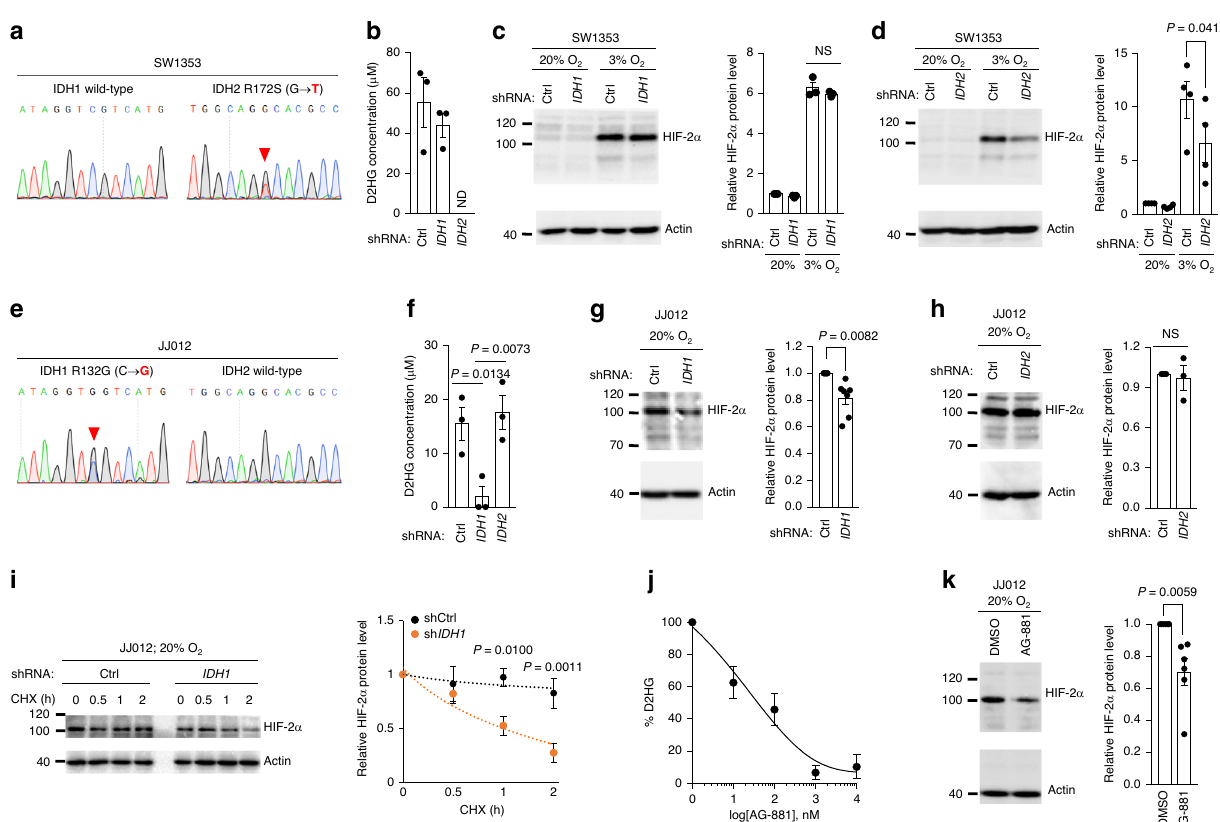
Fig. 5 IDH mutation causes stabilization of HIF-2 α in chondrosarcoma cells. a Sanger sequencing con fi rmed the heterozygous mutation of IDH2 R172S (AGG > AGT) in SW1353 cells. Red arrowhead indicates the mutated site in the IDH2 sequence. b Intracellular D2HG levels in SW1353 cells harboring the indicated shRNA ( n = 3). ND; not detected. c Immunoblot analysis of HIF-2 α protein in SW1353 cells harboring Ctrl or IDH1 shRNA ( n = 3). d Immunoblot analysis of HIF-2 α protein in SW1353 cells harboring Ctrl or IDH2 shRNA ( n = 4). e Sanger sequencing con fi rmed the heterozygous mutation of IDH1 R132G (CGT > GGT) in JJ012 cells. Red arrowhead indicates the mutated site in the IDH1 sequence. f Intracellular D2HG levels in JJ012 cells harboring the indicated shRNA ( n = 3). g Immunoblot analysis of HIF-2 α protein in JJ012 cells harboring Ctrl or IDH1 shRNA ( n = 7). h Immunoblot analysis of HIF-2 α protein in JJ012 cells harboring Ctrl or IDH2 shRNA ( n = 3). i Cycloheximide (CHX) chase analysis of HIF-2 α protein in JJ012 cells harboring Ctrl or IDH1 shRNA. Immunoblots against HIF-2 α and actin (left panel) and densitometric analysis of HIF-2 α band intensities, normalized against HIF-2 α level at the initial time point of each condition ( n = 6, right panel). j Relative D2HG level in JJ012 cells treated with different concentrations of AG-881. The levels were normalized to vehicle treatment ( n = 3). k Immunoblot analysis of HIF-2 α protein in JJ012 cells treated with 2 μ M AG-881 for 72 h. Representative images for immunoblot analysis (left panel) and relative quanti fi cation of HIF-2 α protein level ( n = 6, right panel). Actin was used to verify equal loading of the samples. Data represent mean ± SEM. P -values are from one-way ANOVA ( c , d , f ), two-tailed t test ( g , h , k ), or two-way ANOVA ( i ). NS, not signi fi cant. ( c , d, g – i , k ) Full-size immunoblot images are provided in Supplementary Fig.